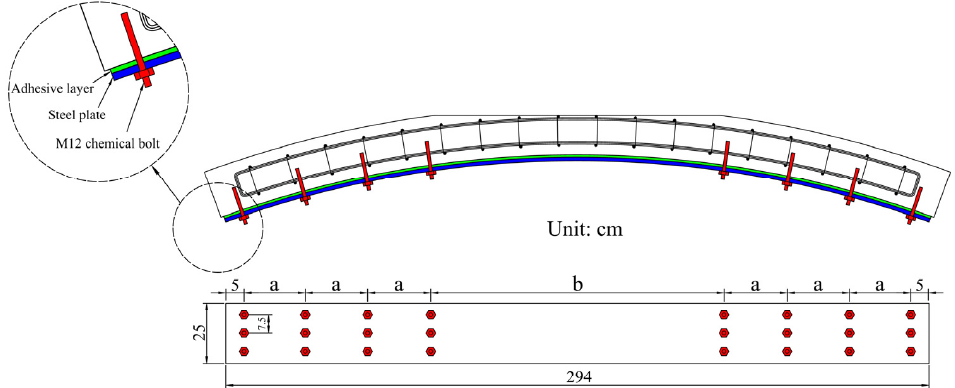
Figure 4. Strengthening scheme and bolt